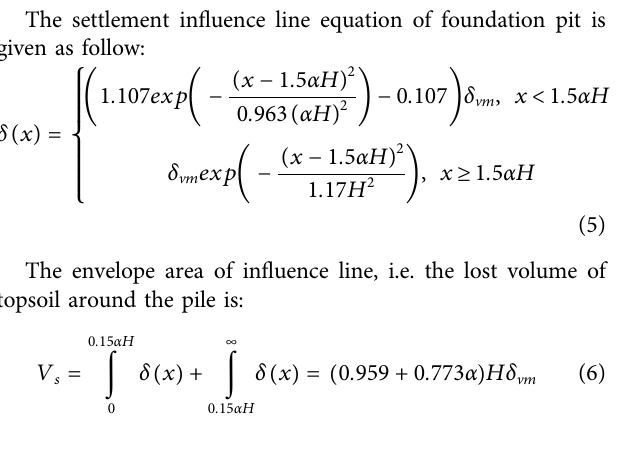
Frontiers in Physics |